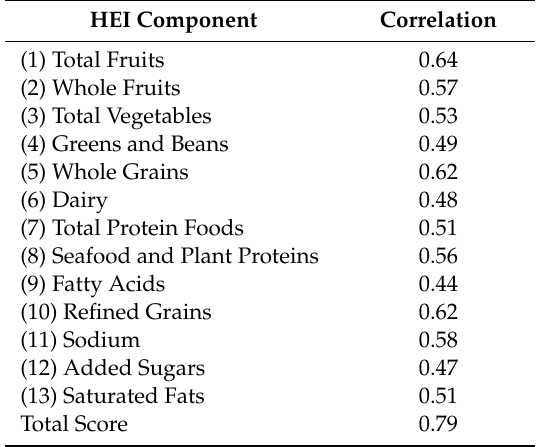
Table 2. The Pearson’s Correlation between the sHEI and the 24 h Recall NDSR in Estimated HEI Component and Total Scores. HEI